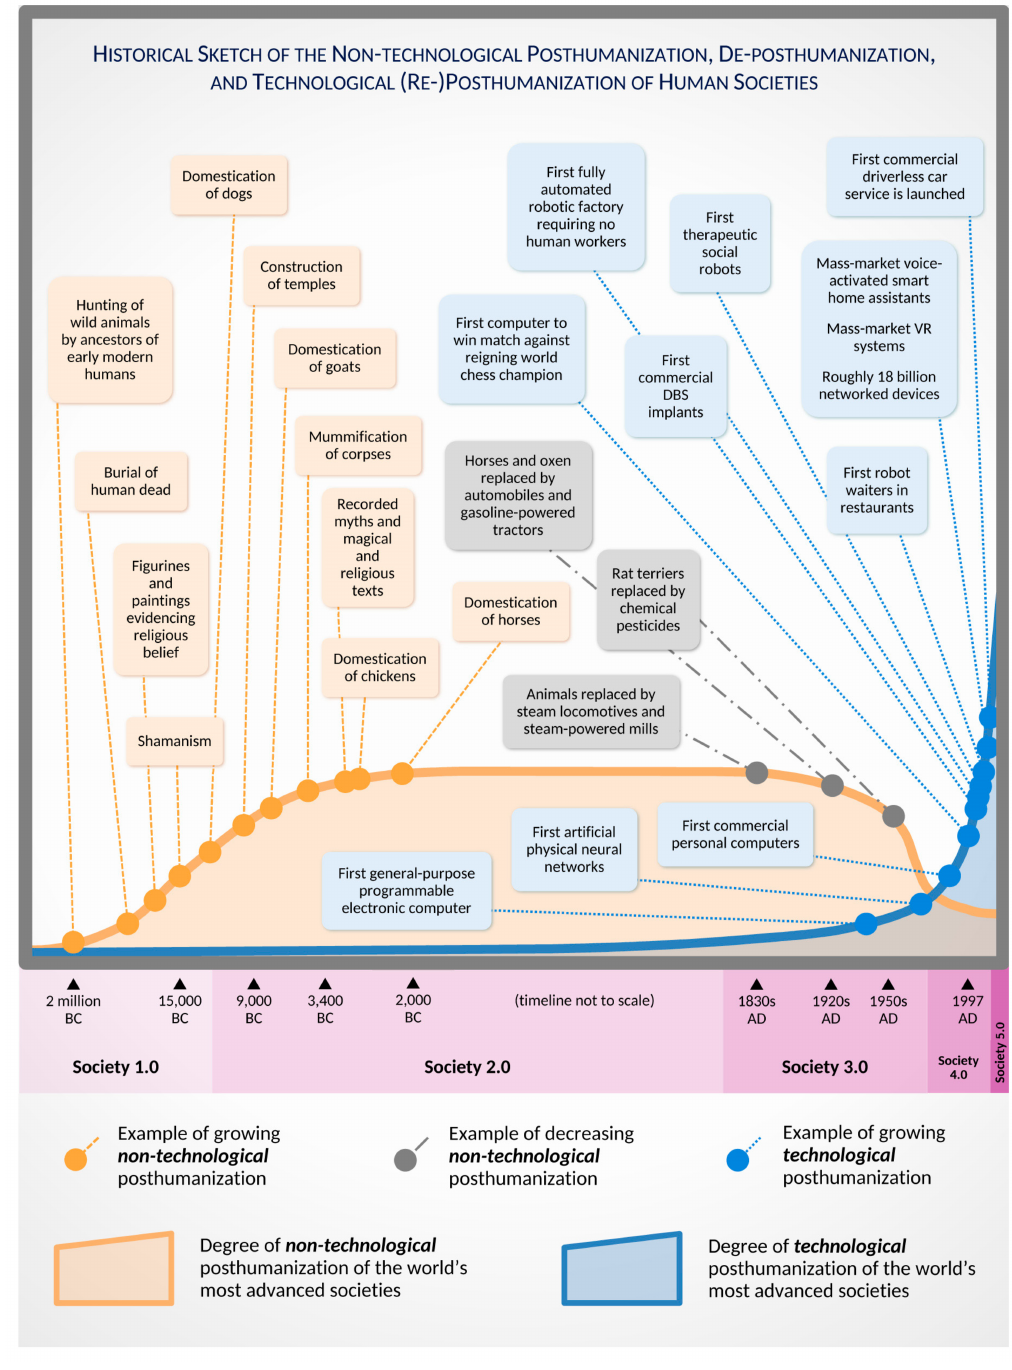
Figure 2. As exemplified by selected historical developments, processes of the ( a ) non-technological posthumanization, ( b ) de-posthumanization, and ( c ) technological (re-)posthumanization of society have set the stage for the emergence of Society